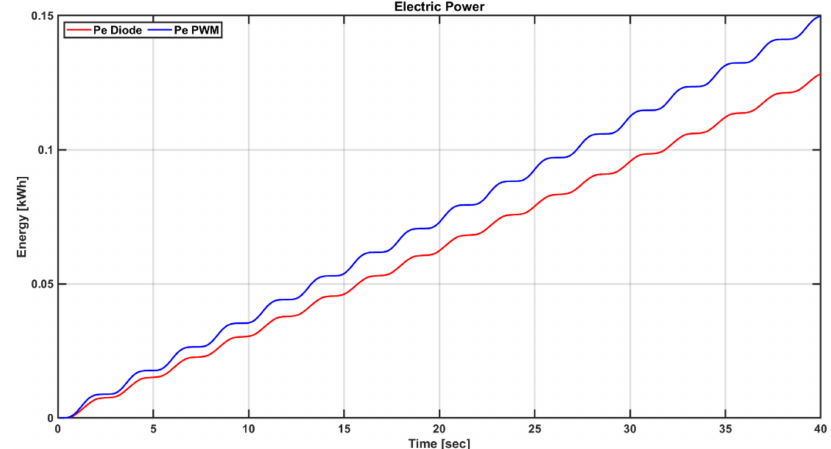
Figure 20. Output energy comparison using integrated simulation of PTO system under high regular wave conditions ( v t = 0~35 m / s and T = 4.75 s).